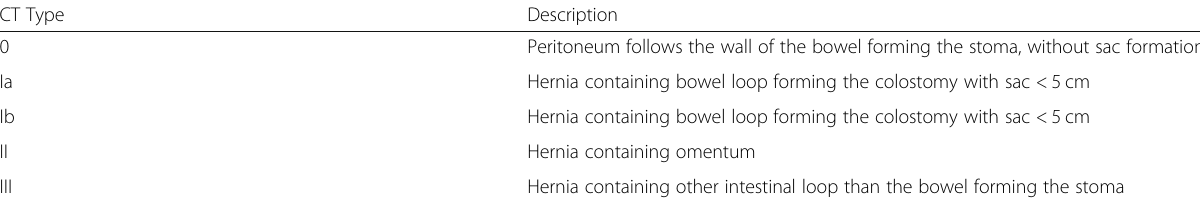
Table 2 CT-based classification system of parastomal hernias. Note: size of the hernia sac differs from that of the abdominal wall defect in EHS clinical classification (Table 1)